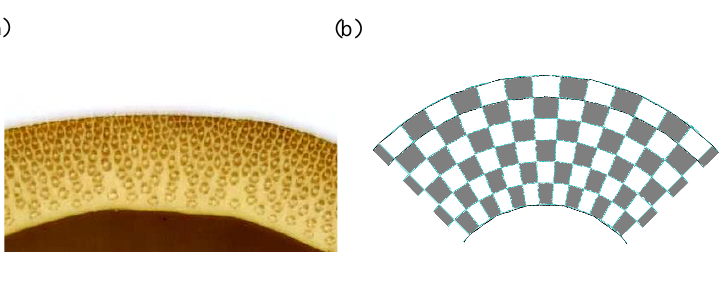
Figure 8. The bamboo-inspired design of lattice cell layout: ( a ) layout of vascular bundle (the photo is taken by the first author); ( b ) bionic layout for lattice